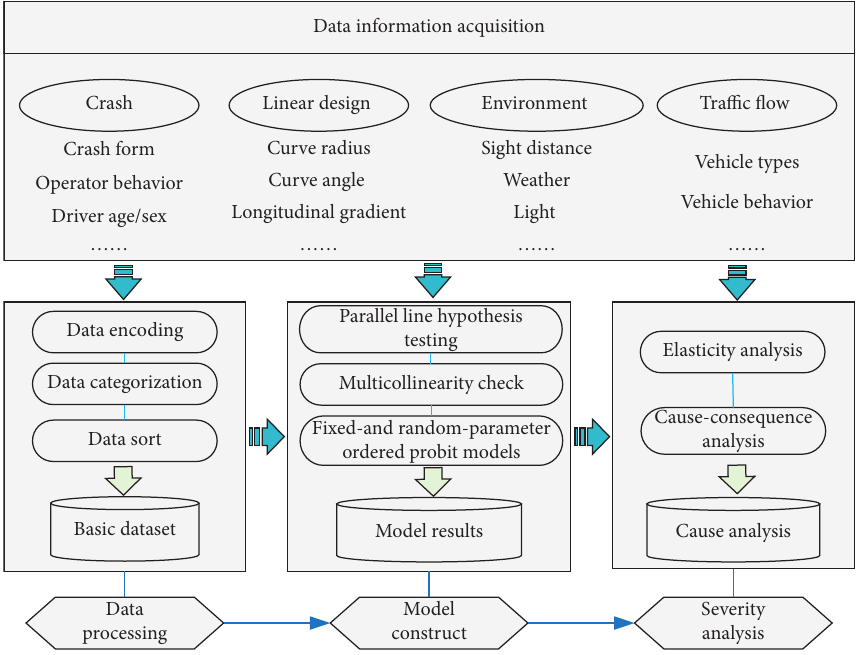
Figure 4: Study framework layout. Table 3: Multicollinearity test variables.